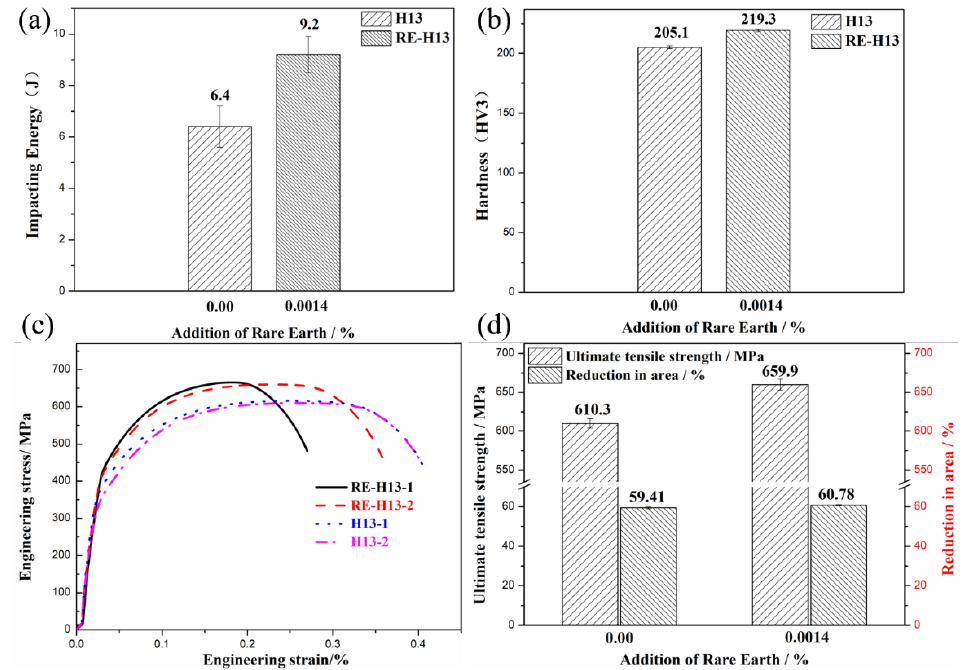
Figure 1. Mechanical properties of tested steels after annealing: ( a ) longitudinal impact energy, ( b ) hardness, ( c ) engineering stress–strain curves of annealed samples, and ( d ) tensile properties of annealed samples.